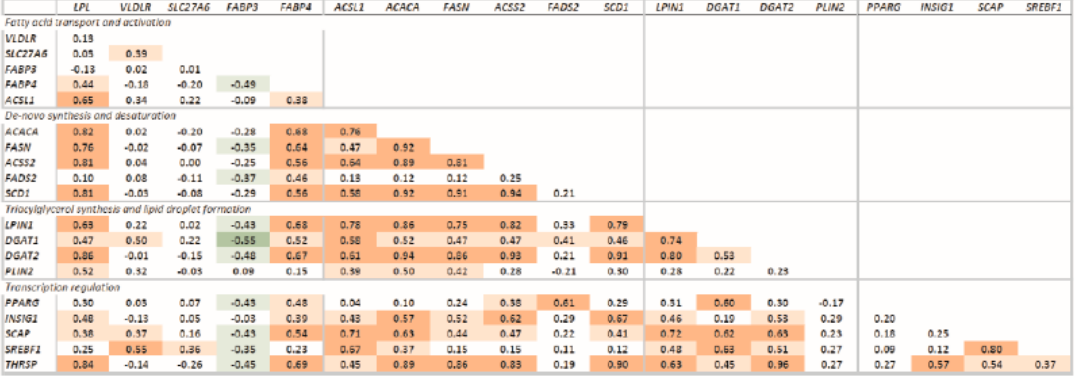
Figure 5. Correlations of the transcription of measured genes. Significant correlations are denoted by bold font and red (positive correlation; p < 0.0001), light red (positive correlation: p < 0.05), green (negative correlation; p < 0.0001), and light green (negative correlation: p < 0.05). Transcripts were grouped based on function.